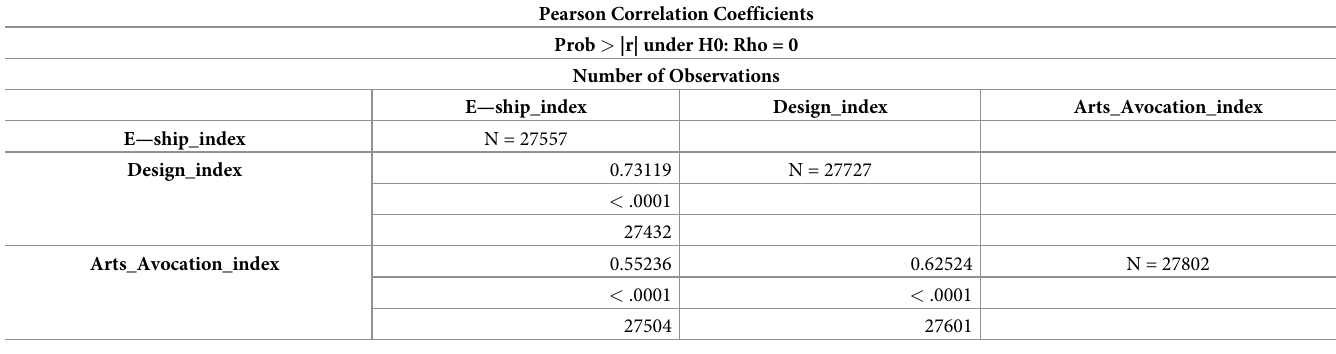
Table 1. Correlation of crafted audience indexes across U.S. ZIP code